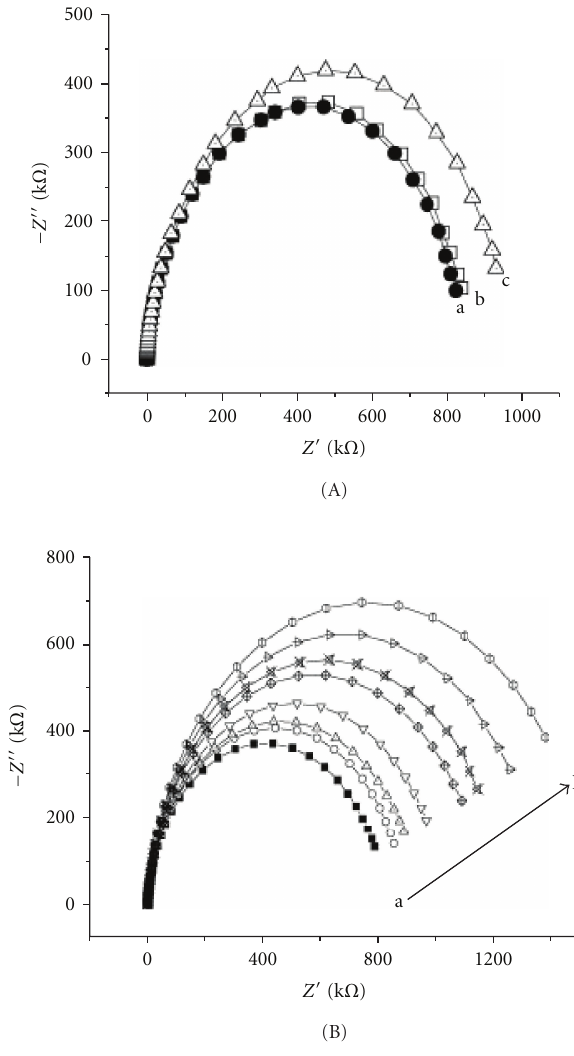
Figure 5: Electrochemical impedance spectra obtained on Con A/MPA/Au electrodes before (a) and after incubation with V. anguillarum. (b) and SRB (c) culture samples (A), and at di ff erent concentrations of SRB ranging from 1 . 8 × 10 3 cfu (colony forming units)/L to 1 . 8 × 10 10 cfu/L (B). Reprinted from [63], Copyright 2009, with permission from